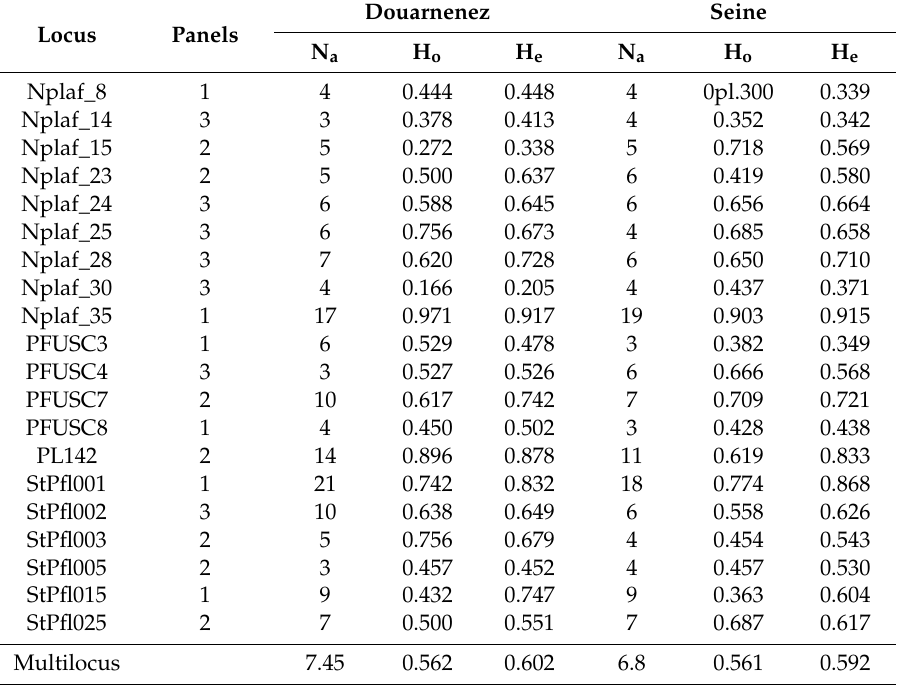
Table 4. Genetic diversity: allelic diversity (Na: Number of alleles), observed heterozygosity (Ho), expected heterozygosity (He) in the Douarnenez bay and the Seine estuary. Locus Panels